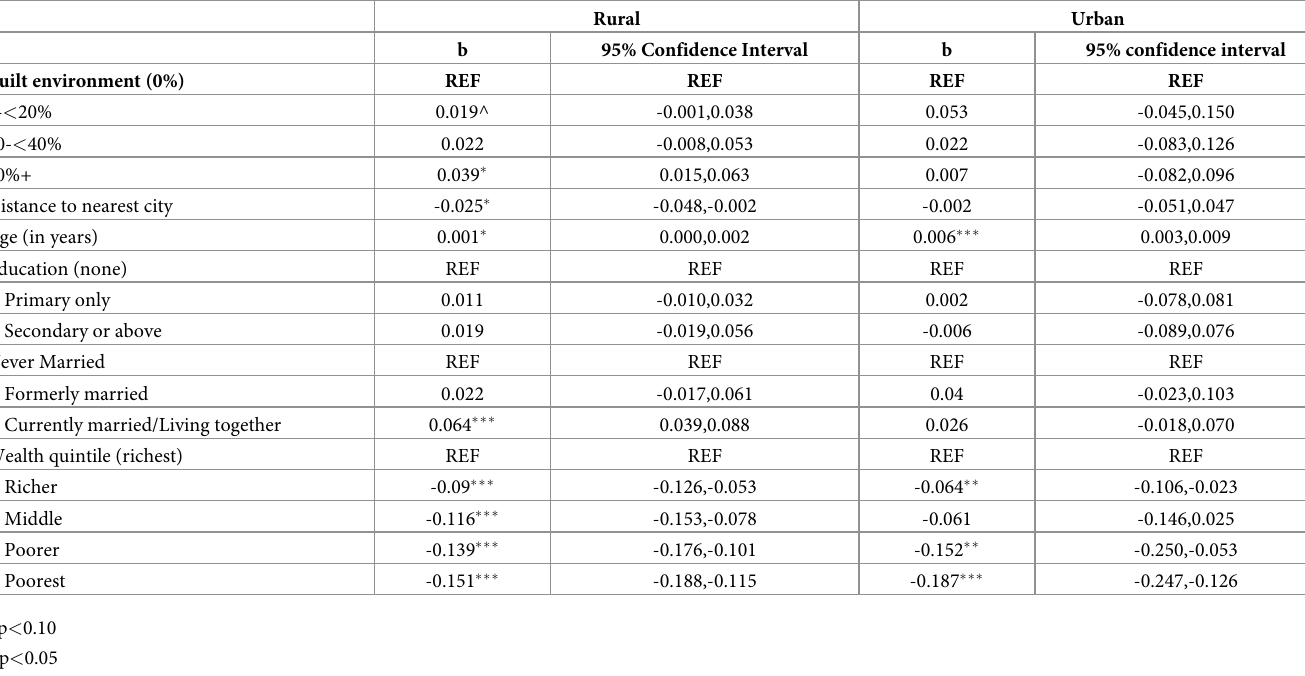
Table 5. Unstandardized beta coefficients from linear regression models of the association between log BMI and built environment stratified by urban/rural